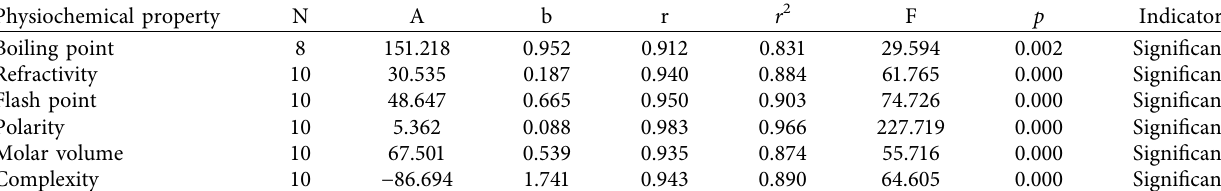
Table 8: Statistical parameters used in the QSPR model of M2(G).